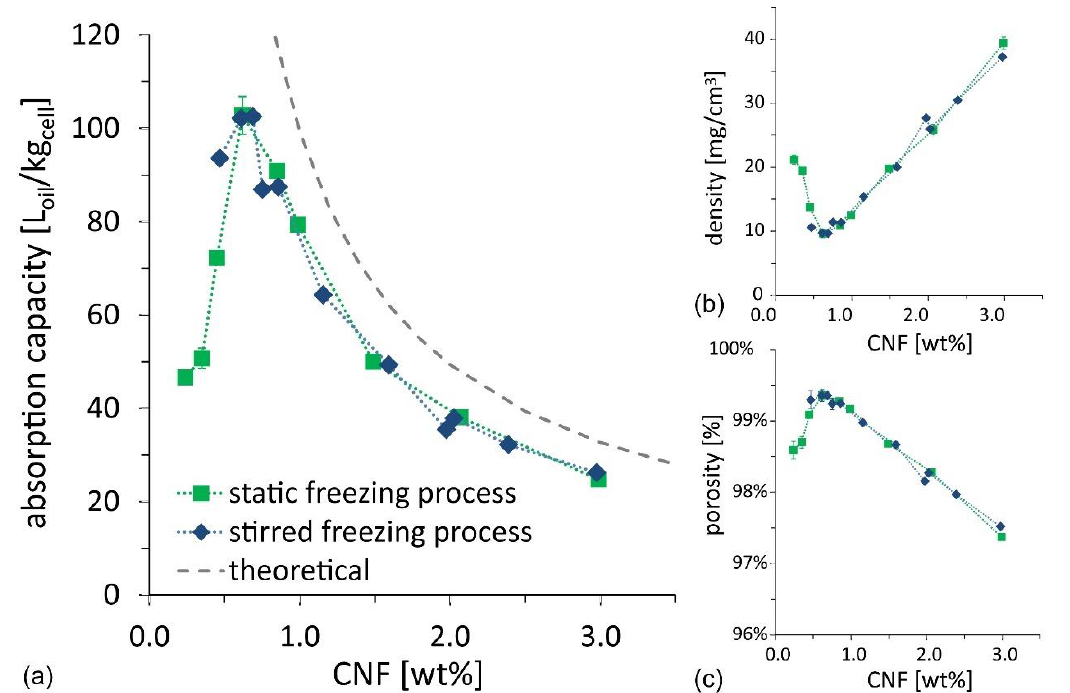
Figure 5. ( a ) Oil absorption capacity as a function of suspension concentration for CNF foams produced using the stirred freezing process (blue diamonds) and the static freezing process (green squares). The expected theoretical absorption capacity is also illustrated; deviation from theory is discussed in the text. ( b ) Density and ( c ) porosity as function of suspension concentration, for CNF foams produced using the compared processes. Lines connecting experimental data are provided to guide the eye.